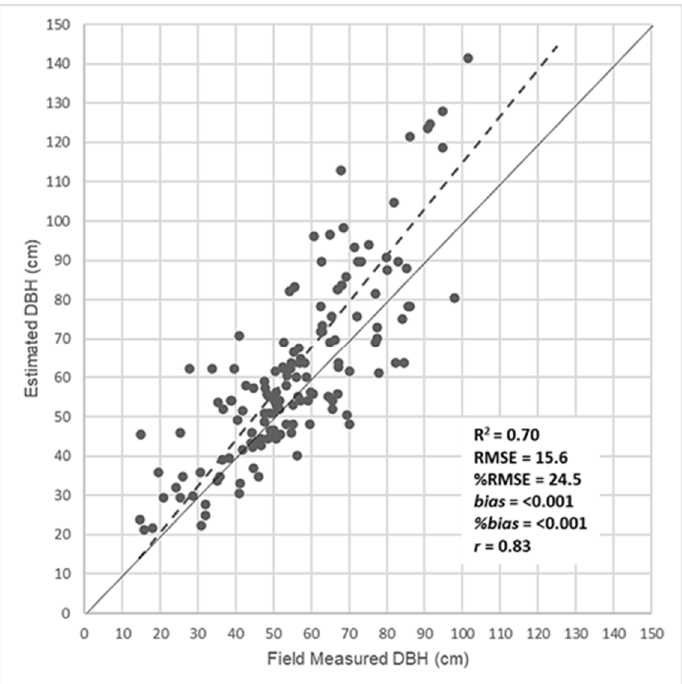
Figure 6. Assessment of the accuracy of the predicted DBH against field measured DBH values. The one-to-one correspondence line is a solid line and the linear fit to the data is a dashed line.